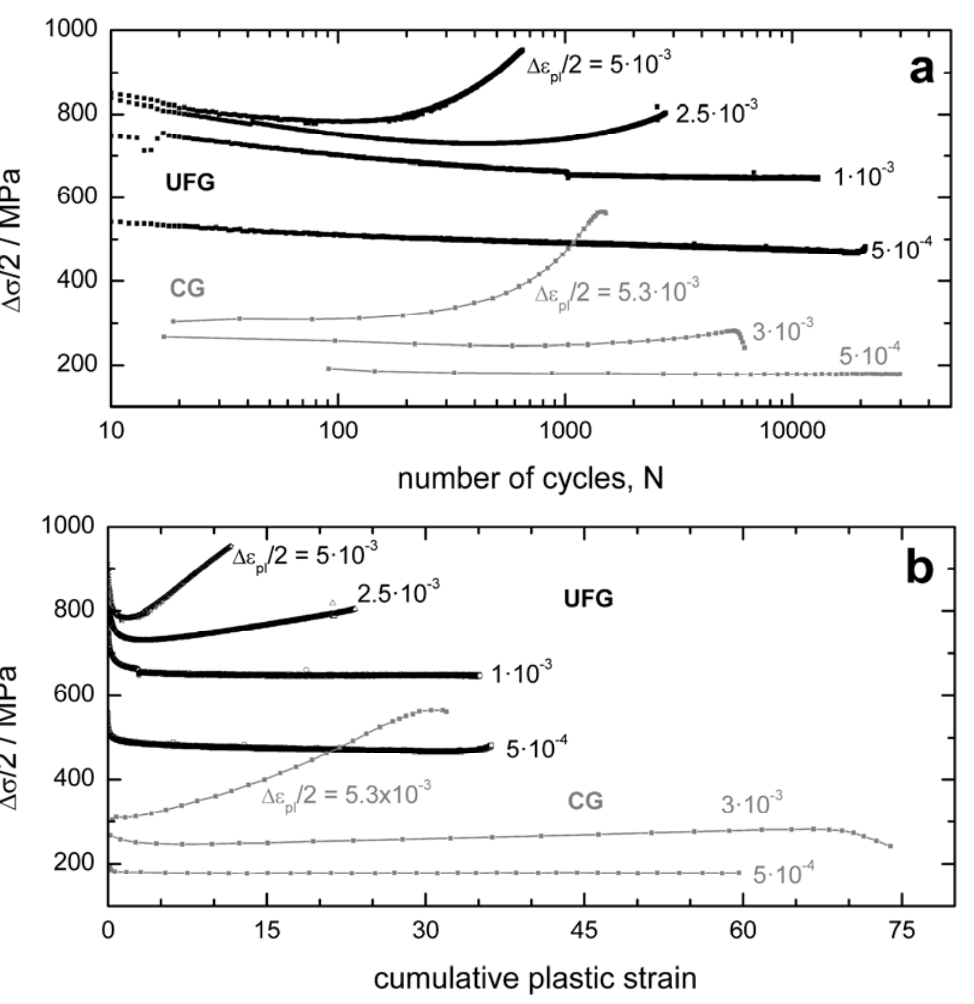
Figure 2. Stress amplitude as a function of the number of cycles ( a ) and of the cumulative plastic strain ( b ) for the UFG condition (black lines). Data for the CG condition (grey lines) has been recompiled from